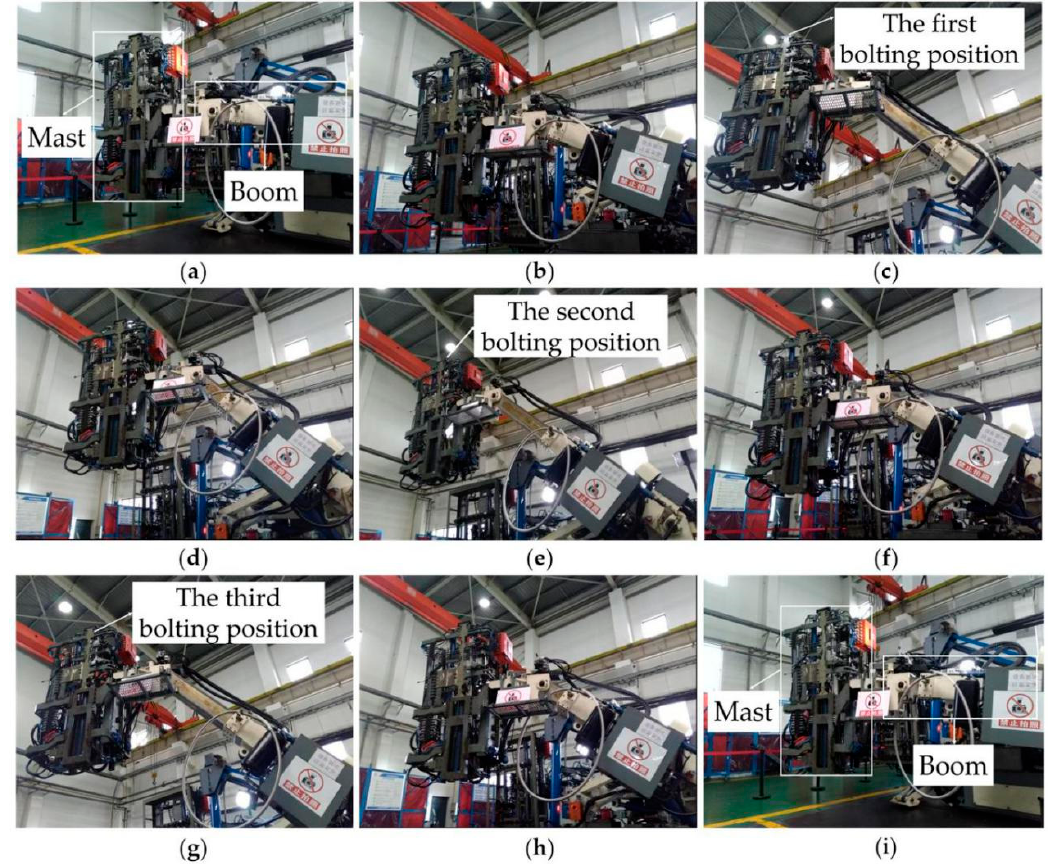
Figure 9. Automatic positioning process: ( a ),( i ) initial position; ( c ) the first bolting position; ( e ) the second bolting position; ( g ) the third bolting position; ( b ),( d ),( f ) the process of moving to the next bolting position; ( h ) the process of returning to the initial position.